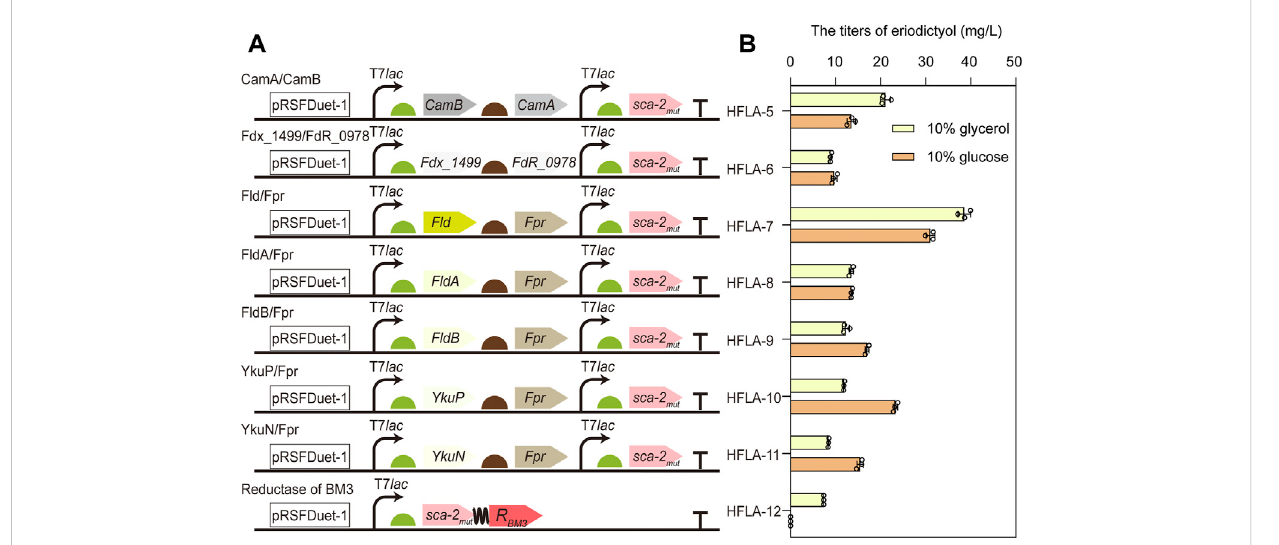
FIGURE 3 Improving the catalytic activity of sca-2 mut by engineering redox partners. (A) Schematic representation of combining sca-2 mut with different redox partners to reconstitute the activity of sca-2 mut . Redox partners included Fdx_1499/FdR_0978, Fld/Fpr, FldA/Fpr, FldB/Fpr, YkuP/Fpr, YkuN/Fpr, and the reductase domain of BM3. (B) Titers of eriodictyol produced by different sca-2 mut whole-cell biocatalysts with different redox partners using 100 mg/L naringenin. The data are shown as mean ± SD of three biological